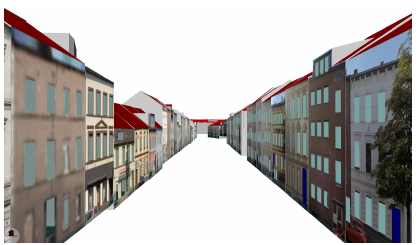
Figure 11. Enhanced R-CNN